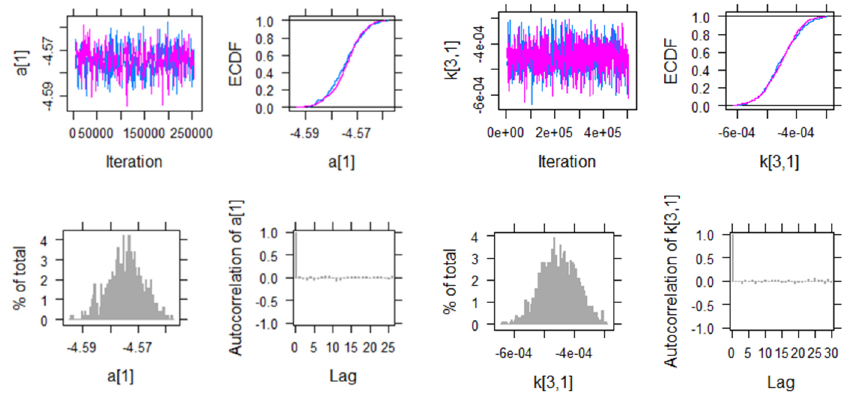
Figure 1. History plot ( top left ), posterior distribution function ( top right ), posterior density function (histogram; bottom left ), and autocorrelation plot ( bottom right ) of α ( 60 ) (left panel) and κ ( 3 ) ( 1970 ) (right panel), with two chains of simulations (pink and blue).